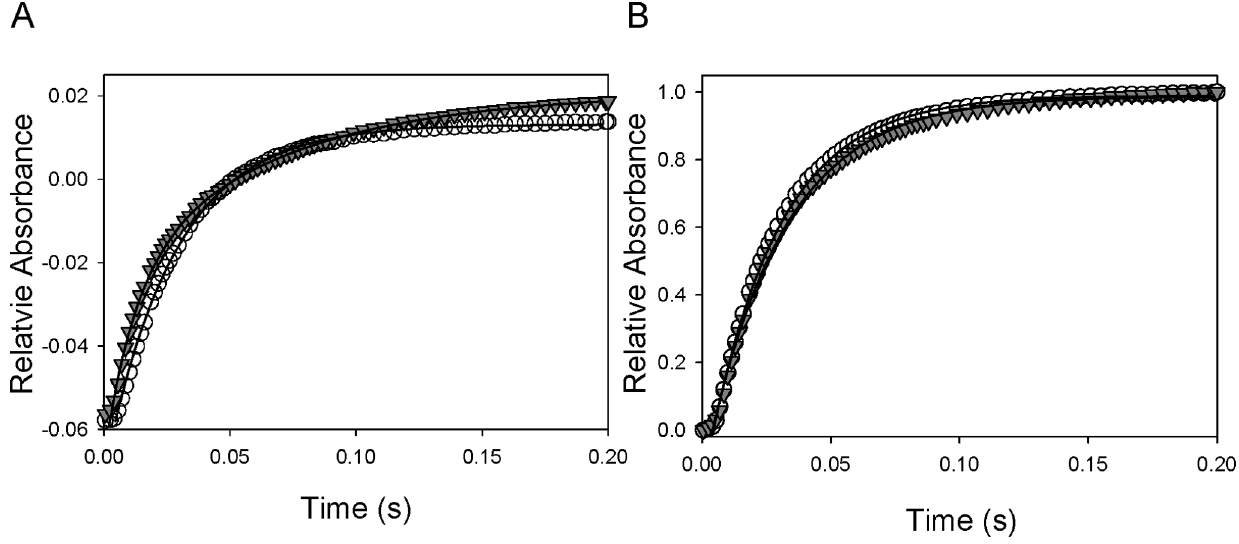
Figure 4. Stopped-flow kinetics of oxygen dissociation from Hbs in the presence and absence of Hp. A. The time courses of oxygen dissociation from HbA (open cirlce), and the Hb and Hp complex (gray triangle) mixed with 1.5 mg/mL sodium dithionite (Na 2 S 2 O 4 ) were plotted for comparison. B. The time courses of oxygen dissociation from bb XLHb (open circle), and the bb XLHb complex with Hp (gray triangle) were illustrated.